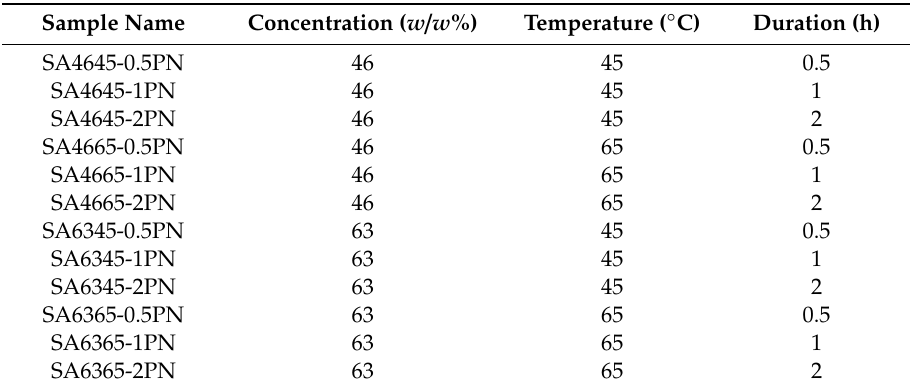
Table 1. Hydrolysis conditions and sample names in P-CNCs.